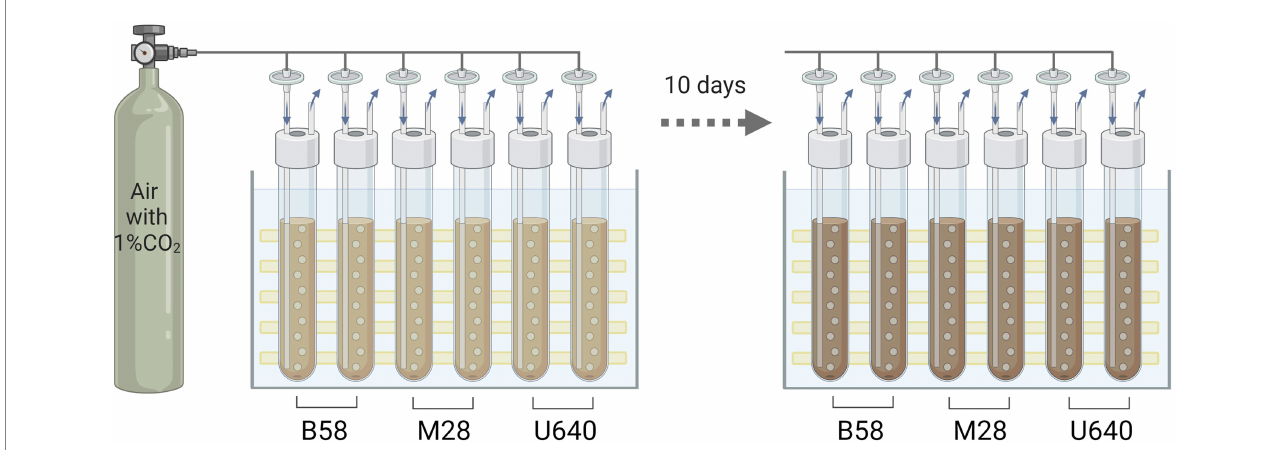
FIGURE 2 Experimental setup for batch experiment in bubble columns. Batch cultures of three Phaeodactylum tricornutum strains were grown at controlled growth conditions until stationary phase was reached, with 2 biological replicates for each strain. Cultures were kept at a temperature of 24 ° C, bubbled with air enriched with 1% CO 2 , and irradiance was increased from 30 to 500 μ mol m − 2 s − 1 with increasing biomass concentration. Samples for optical density were taken daily and for cell count and microbiome analysis on Days 0, 5, and 9 (U640) or 10 (B58, M28). Figure created with